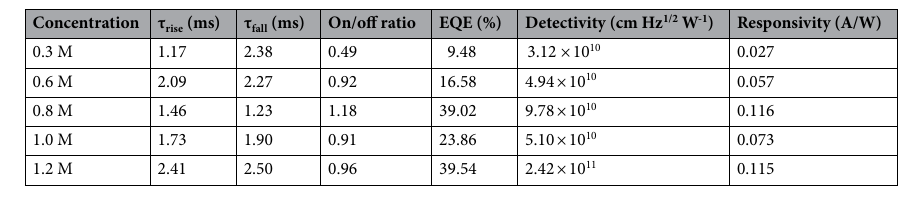
Table 4. Comparison of photodetector parameters for different film thicknesses at 365